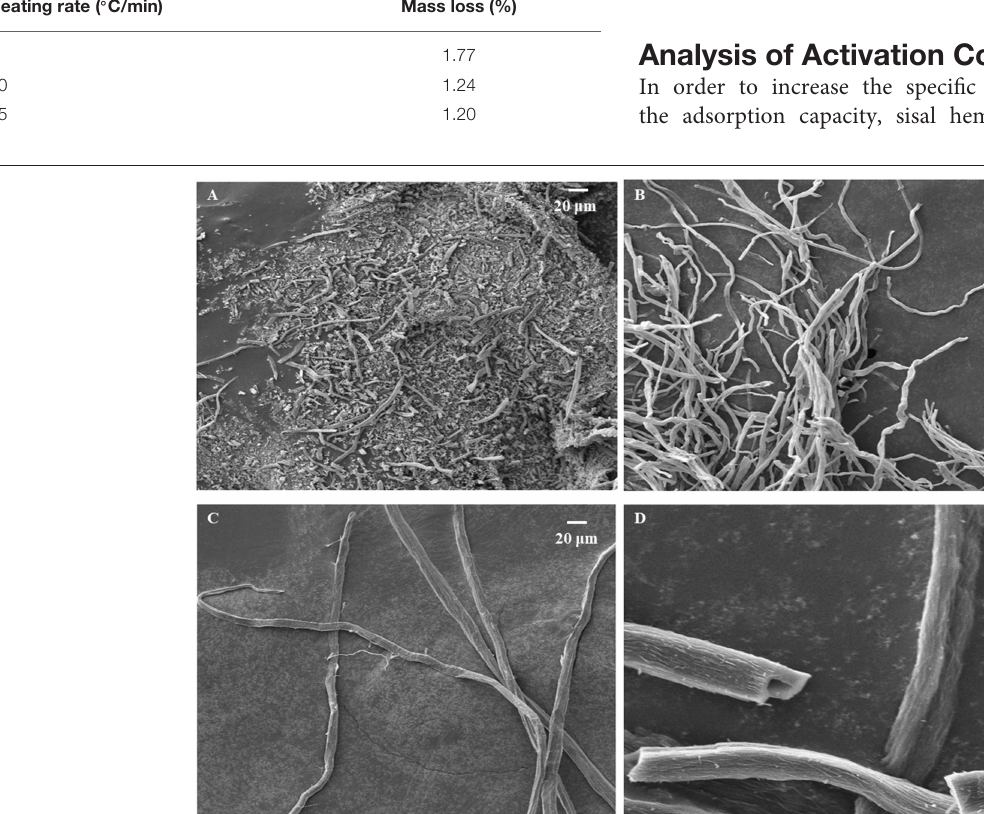
TABLE 3 | Mass losses of sisal hemp pulp-based paper at 400–600 ◦ C at different heating rates (5, 10, and 15 ◦ C/min). Heating rate ( ◦ C/min)